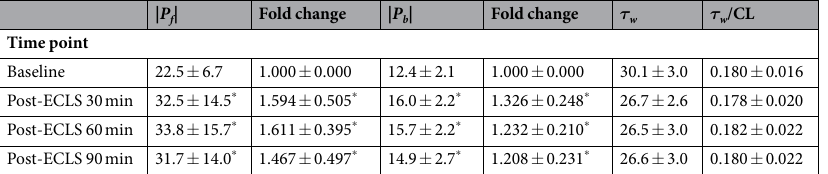
Table 3. Effects of ECLS on the pulse wave reflection obtained from aortic pressure waveform in rats at baseline and at 30, 60, and 90 min post-ECLS. Variables are expressed as median ± interquartile range (IQR). CL = cardiac cycle length (ms); | P f | = magnitude of forward pressure wave (mmHg); | P b | = magnitude of reflected pressure wave (mmHg); τ w = arterial wave transit time (ms). * P < 0.05 compared with